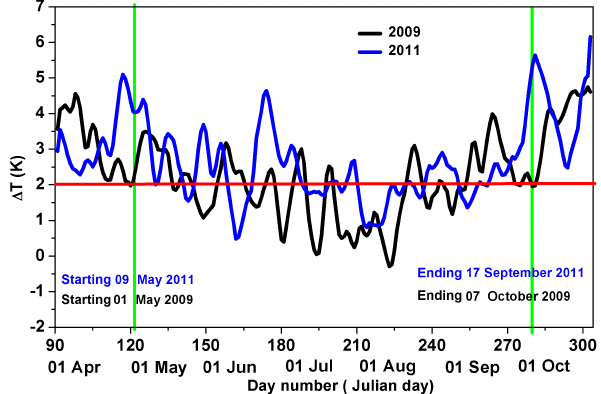
Figure 2. Time series of (cid:49)T for beginning and end of MI from April to October 2009 (black) and 2011 (blue). Green vertical lines show beginning (1 May 2009) and end (7 October 2009) time for